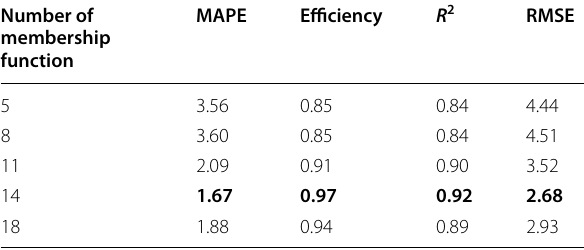
Table 9 Influence of the various number of membership functions on PSO–DA ANFIS.